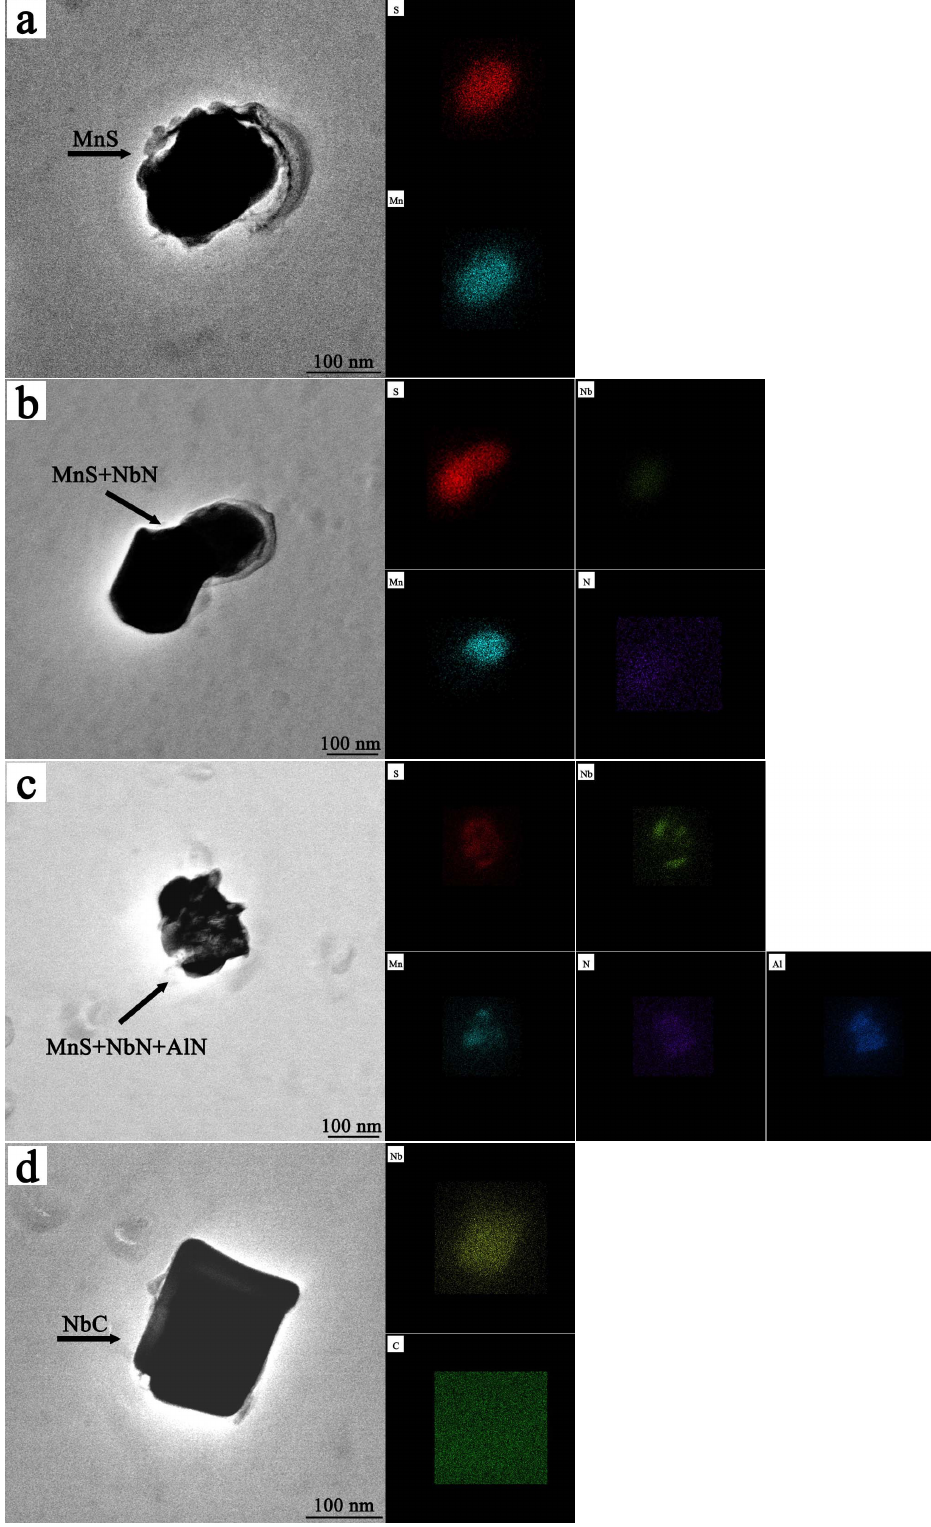
Figure 1: Precipitates morphologies observed by TEM and EDS elemental mapping of precipitates: (a)MnS, (b)MnS+NbN, (c)MnS+NbN+AlN, and